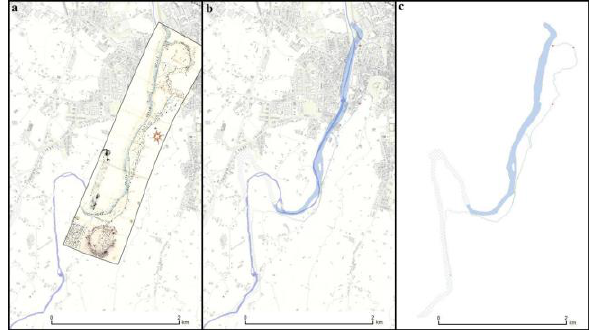
Figure 11. Results from georeferencing (a) and vectorization (b, c) of the 1757 map; in (a) and (b) the current CTC is in background. The scale bar is 2 km long